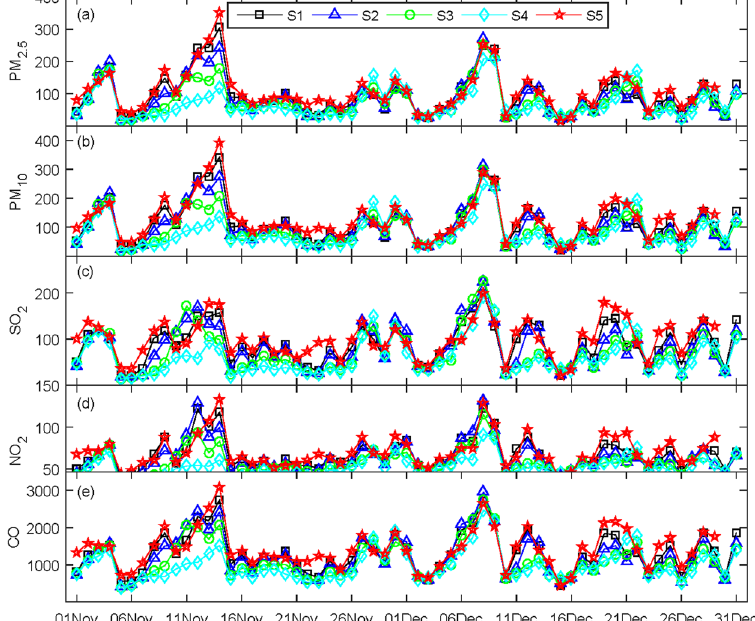
Figure 5. The daily concentrations of PM 2.5 ( a ), PM 10 ( b ), SO 2 ( c ), NO 2 ( d ) and CO ( e ) in downtown Beijing during November-December 2015 derived from the simulations using different scenarios in μ g/m 3 .